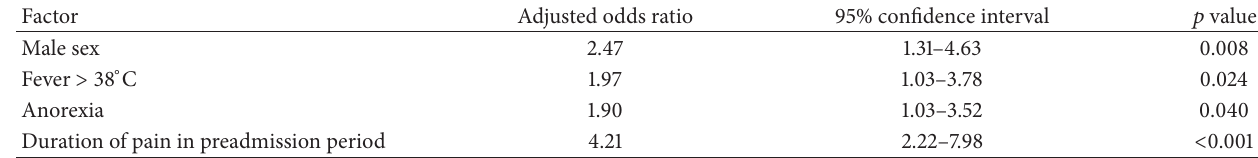
Table 4: Factors associated with perforated appendicitis by multivariate analysis.